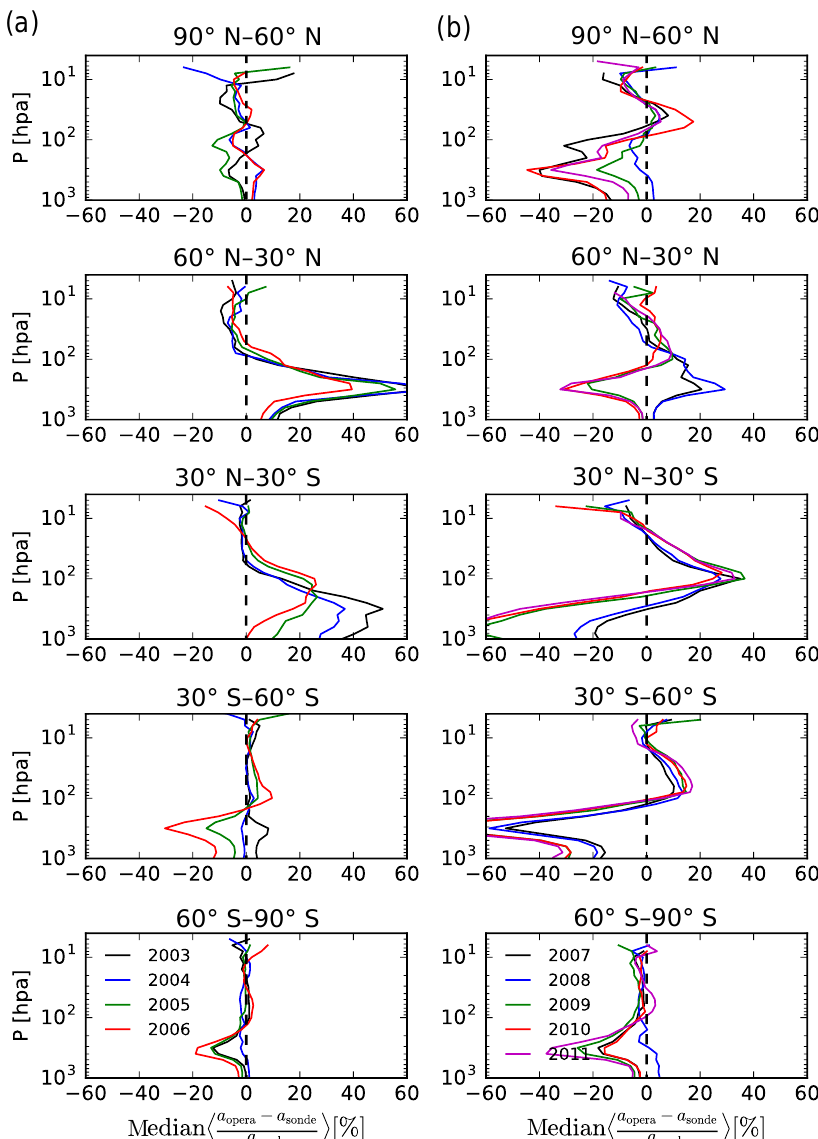
Figure 8. Relative difference between ozone profiles retrieved using SCIAMACHY L1 v8 data and convolved ozone sonde profiles, for the period 2003–2011. Results are shown for five latitude bands as indicated. Panel (a) shows results for the years 2003–2006 and panel (b) for the years 2007–2011. Solid lines are median differences of retrieved profiles and sonde profiles [(retrieval – sonde)/sonde] in